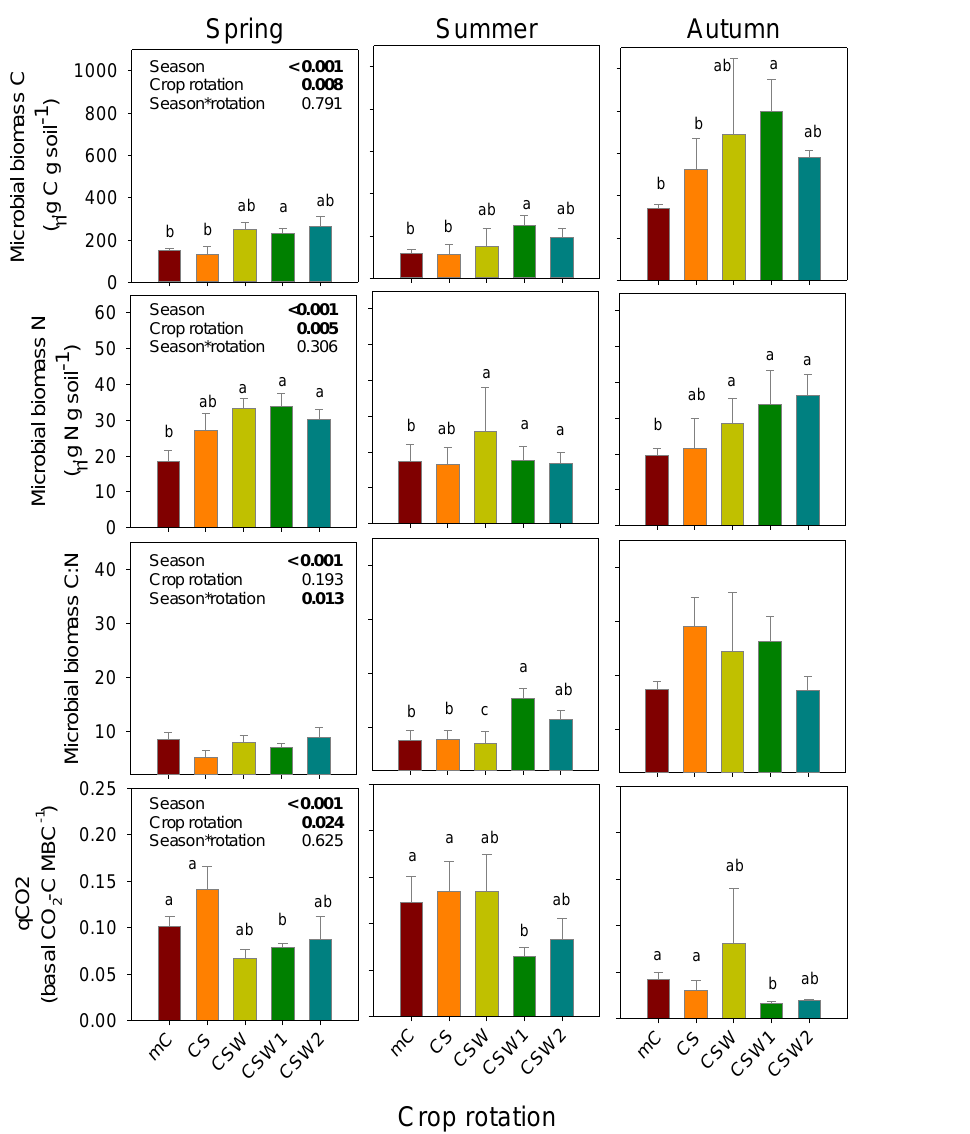
Figure 2. Soil microbial biomass parameters by season and crop rotation. See Fig. 1 for crop rotation abbreviations. Means are shown and error bars are standard errors ( n = 4). P values from ANOVA results are shown for each variable with the main effects (season and crop rotation) and the interaction, as well as significant differences from post hoc results shown as lowercase